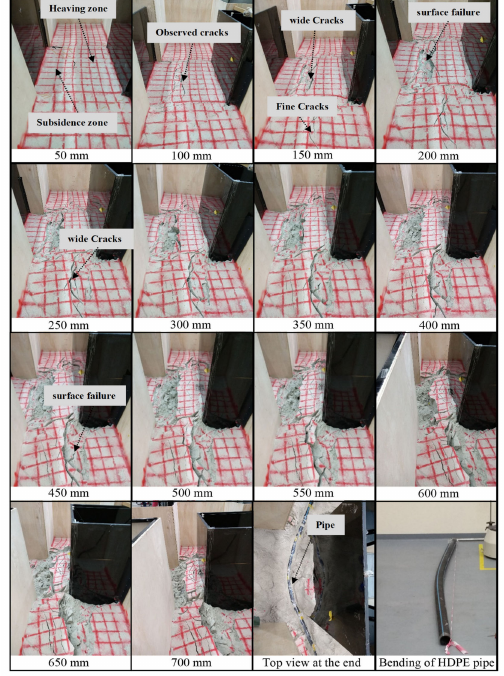
Figure 8. Surface displacement of the soil in increasing 50 mm stages by the movement of a plate. Soil cracks are observed at different stages and the pipe